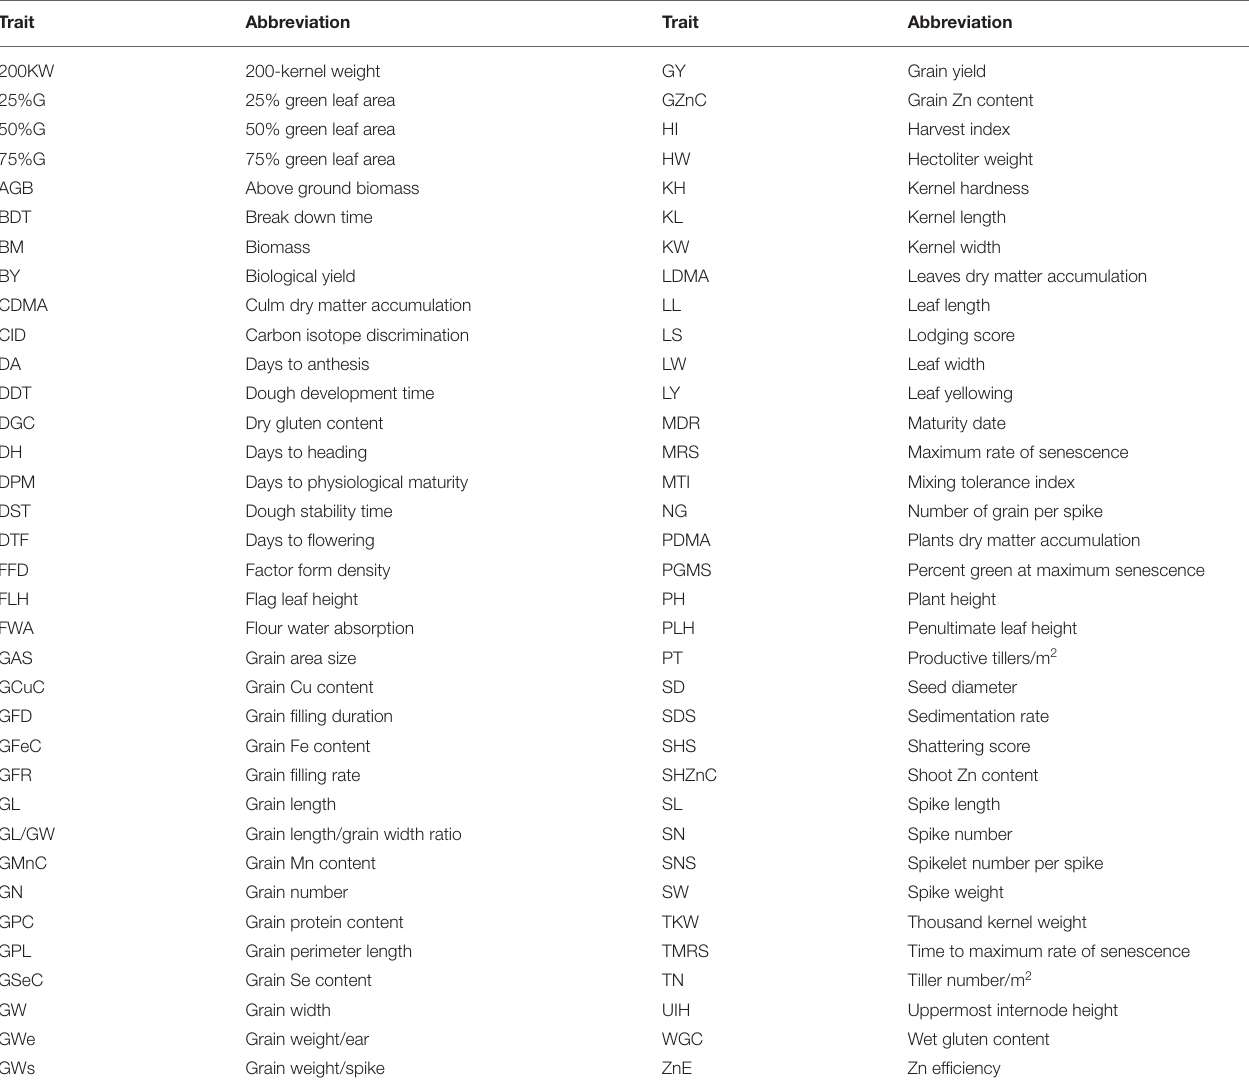
TABLE 1 | The list of assessed traits in meta-quantitative trait loci (MQTL) analysis.